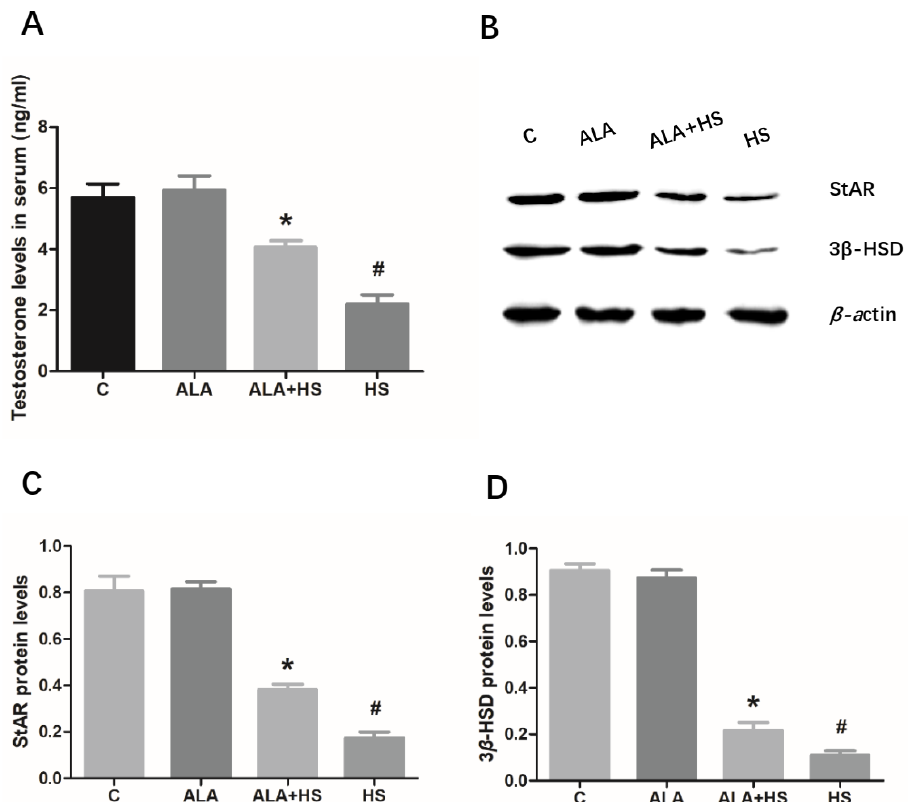
Figure 5. The effect of alpha lipoic acid on serum testosterone levels in chickens exposed to heat stress. ( A ) Serum testosterone concentration was determined using a commercial ELISA kit. ( B ) Western blotting was used to analyze the expression of the key steroidogenic-related proteins, StAR and 3 β -HSD. ( C ) StAR and ( D ) 3 β -HSD protein expression levels were normalized to β -actin levels. The statistical analysis results are shown as bar graphs. The data are presented as the mean ± SE of three independent experiments. Note: * p < 0.05 vs. HS group; # p < 0.05 vs. C group.